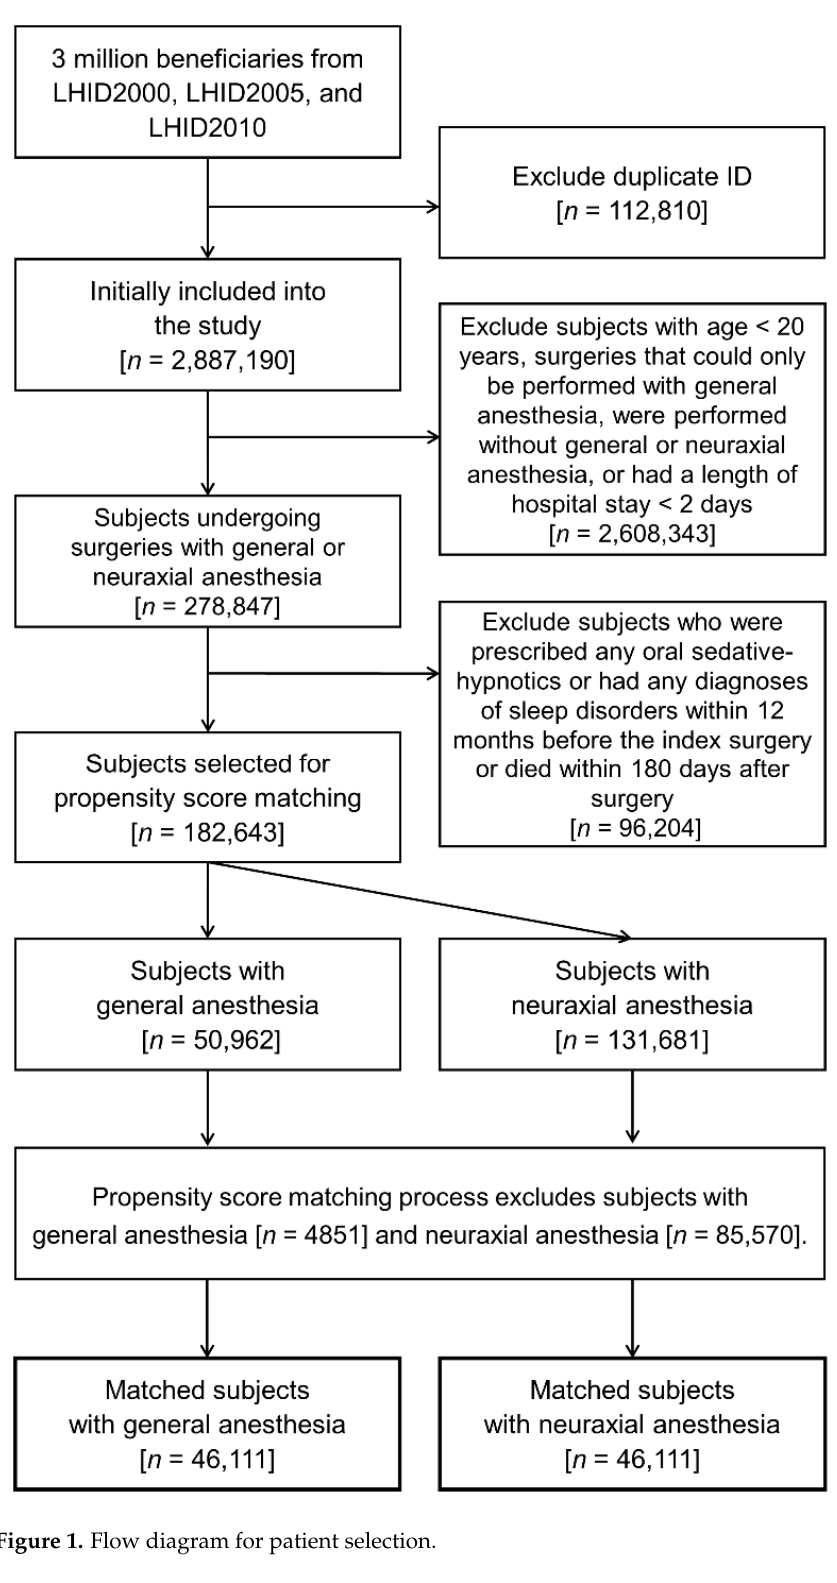
Figure 1. Flow diagram for patient selection.